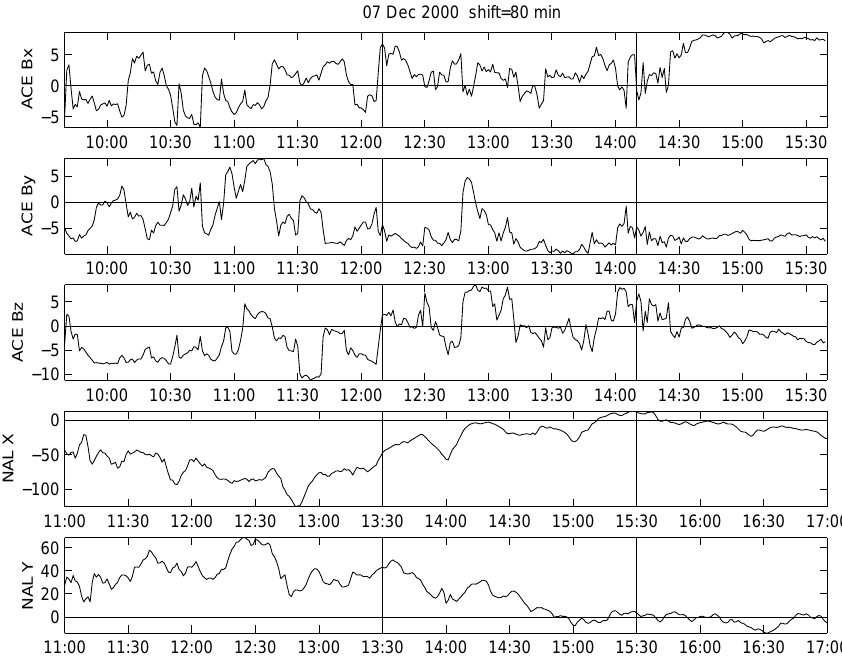
Fig. 1. IMF B X , B Y , and B Z (GSE-coordinates) by the ACE satellite (three first panels) and magnetic field north and east components as recorded at Ny ˚Alesund (NAL). The vertical lines show the period of auroral activity at